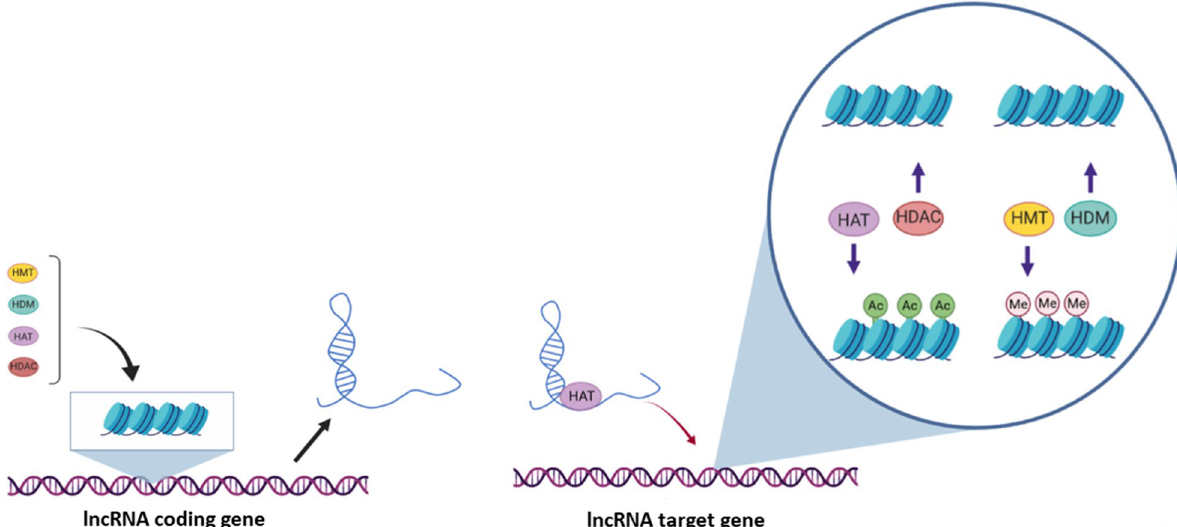
Fig. 2 Interaction between lncRNA and histone modifications. A The expression level of lncRNAs can be regulated by histone modification mechanisms. B lncRNAs can affect histone modification mechanisms, including histone acetylation and histone